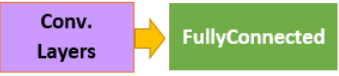
Figure 5. General structure of a CNN.